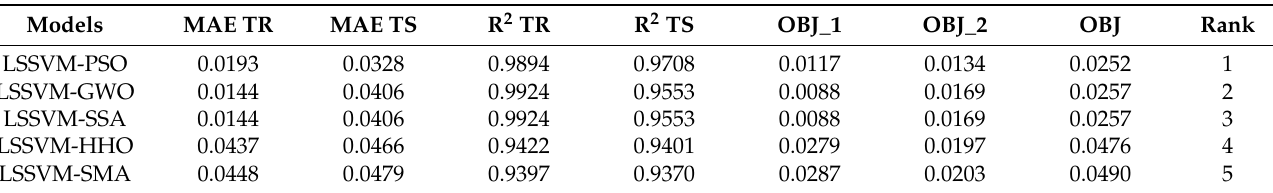
Table 9. Details of OBJ creation